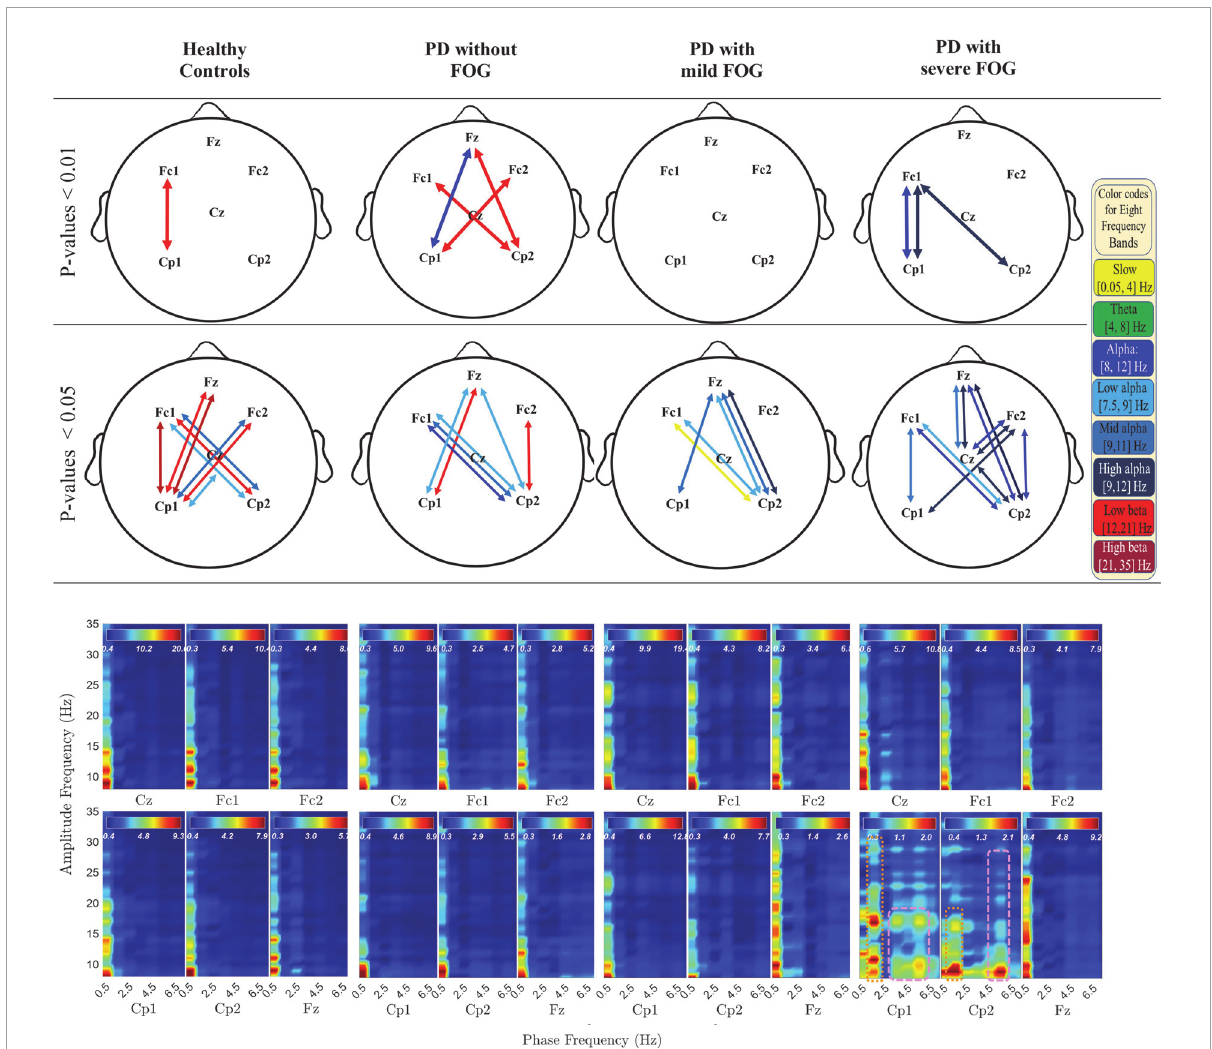
FIGURE3 Significant PLV between different channels over different frequency bands (top two rows) and PAC coupling between lower frequency bands (slow cortical potentials and theta) and higher frequency bands (alpha and beta frequency bands) (bottom row) without SL in all groups. In the top row, different colors represent different frequency bands: Yellow: slow cortical potentials; green: theta; navy blue: alpha; light blue: low alpha; blue: middle alpha; dark blue: high alpha, light red: low beta; dark red: high beta. First and second row represent significant PLVs for p < 0.01 and p < 0.05, FDR-corrected, respectively. In the lower row, PAC between lower frequency bands (slow cortical potentials and theta) and higher frequency bands (alpha and beta frequency bands) without SL over [–3, 1] s is presented for all groups. Dashed pink lines represent the coupling of the phase of theta with alpha and beta frequency bands. Pink dotted lines represent the PAC between higher slow cortical potentials and alpha and beta.